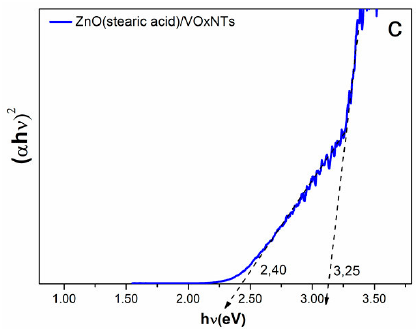
Figure 3. Tauc plots of indirect bad gap determination of ( a ) ZnO (stearic acid), ( b ) VOx ‐ NTs and ( c ) nanocomposite hybrid ZnO/VOx ‐ NTs.